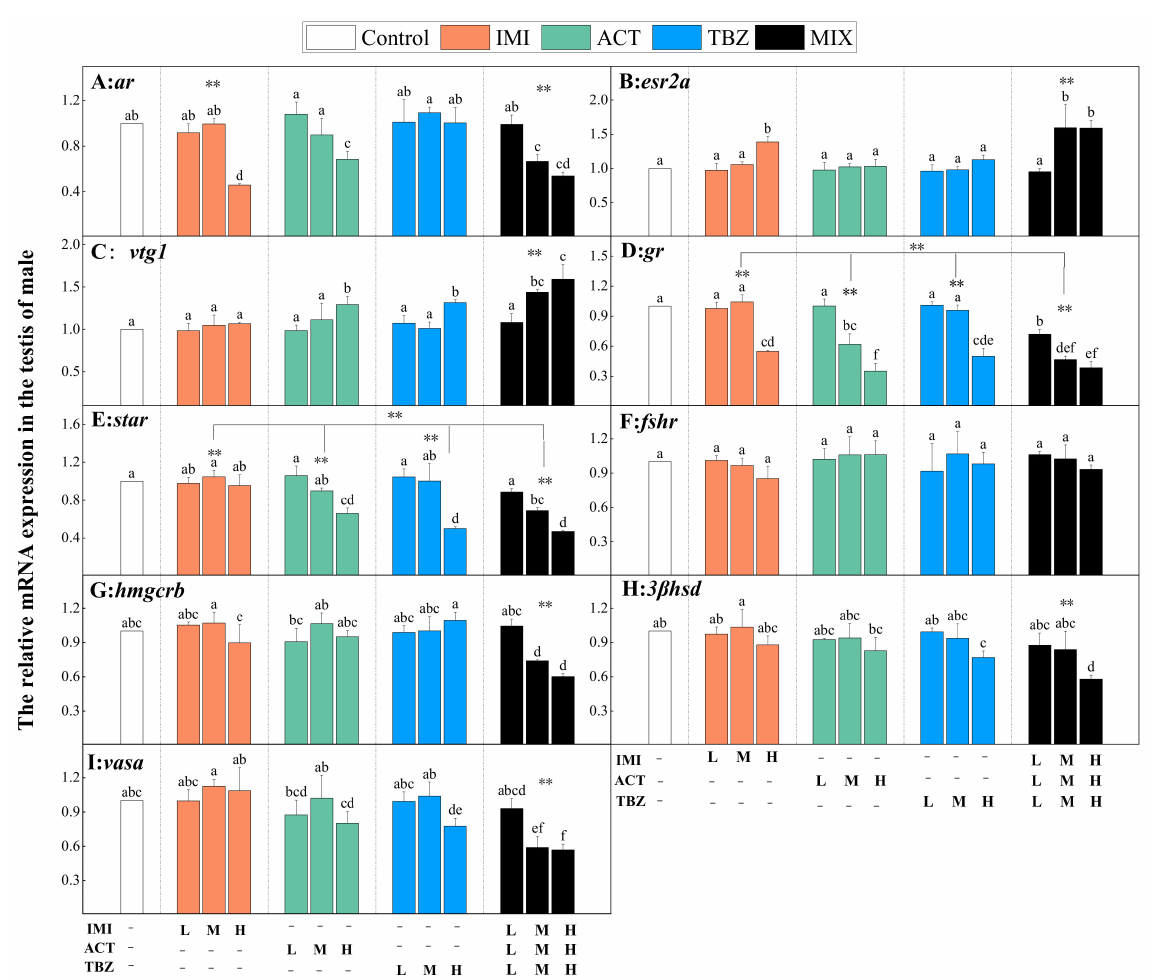
Figure 6. Expressions of reproductive genes ( A ) ar , ( B ) esr2a , ( C ) vtg1 , ( D ) gr , ( E ) star , ( F ) fshr , ( G ) hmgcrb , ( H ) 3 β hsd and ( I ) vasa in the testes of the males. Values are presented as mean ± standard deviation (n = 3) ( p < 0.05). Here L: low concentration, M: medium concentration and H: high concentration. In the figure, “a, b, c, . . . ” indicate that the results were analyzed by one-way ANOVA; “* and **” indicate the significant differences between the exposure groups and the control and the results were analyzed by two-way ANOVA (*: p < 0.05; **: p <